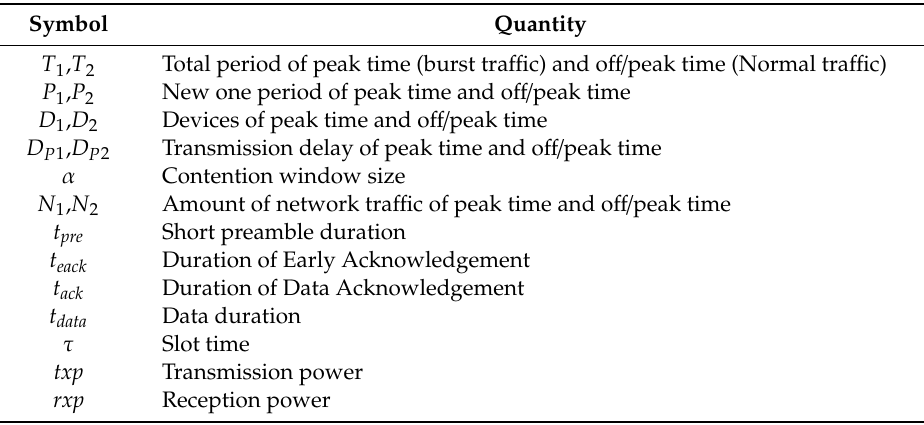
Table 2. Symbols for equations: DDC-MAC.